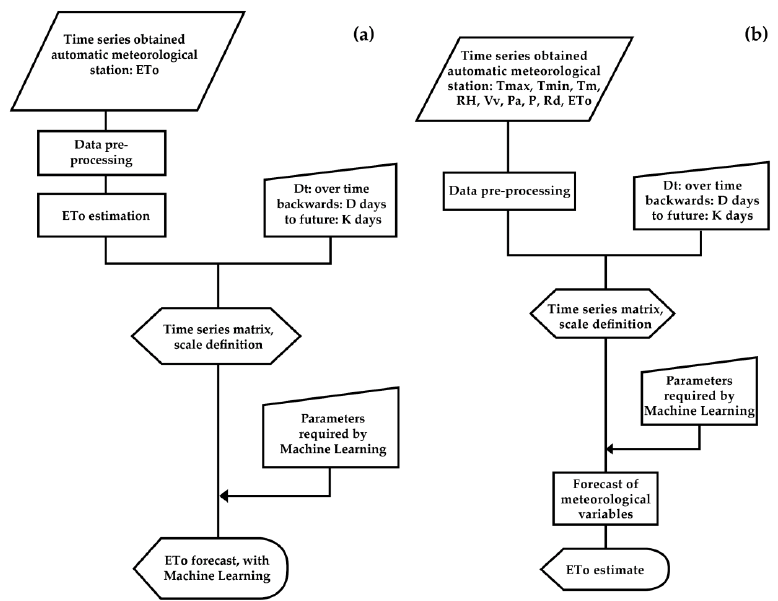
Figure 3. ETo forecasting approaches: ( a ) Direct approach; ( b ) Indirect approach; adapted from Torres et al. (2011) [7].